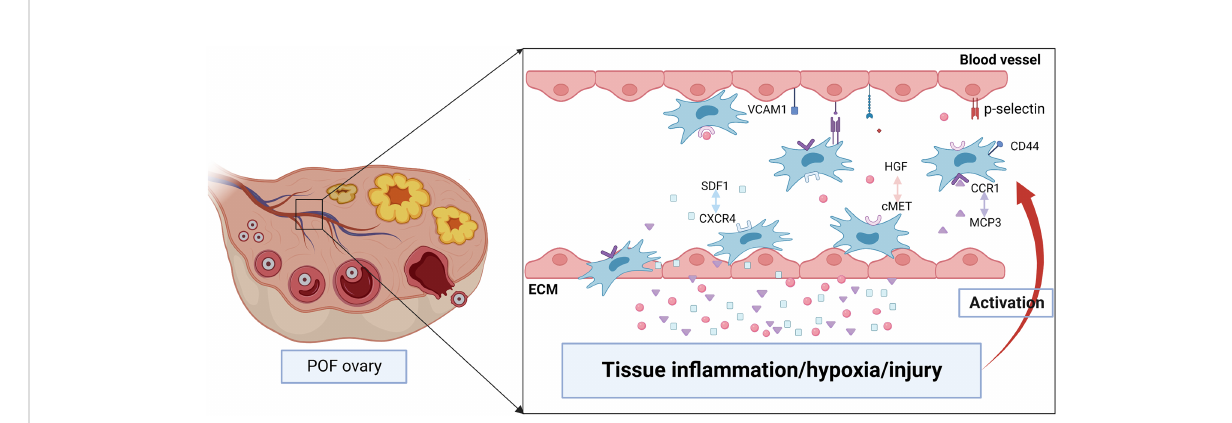
FIGURE 3 The possible mechanisms of BMSCs homing to injured ovary. Tissue in fl ammation, hypoxia or injury may induce the high level of chemokines including stromal cell derived factor 1 (SDF1), hepatocyte growth factor (HGF), monocyte chemotactic protein-3 (MCP3). They are released into the bloodstream and promote BMSCs proliferation as well as express speci fi c receptors such as CXC chemokine receptor 4 (CXCR4), cMET, CC chemokine receptor 1(CCR1). After binding with the ligand, BMSCs migrate to the injured tissue along the gradient of chemokines concentration. In addition, various adhesion molecules including CD44, p-selectin, vascular cell adhesion molecule 1 (VCAM1) participate in regulating the homing of